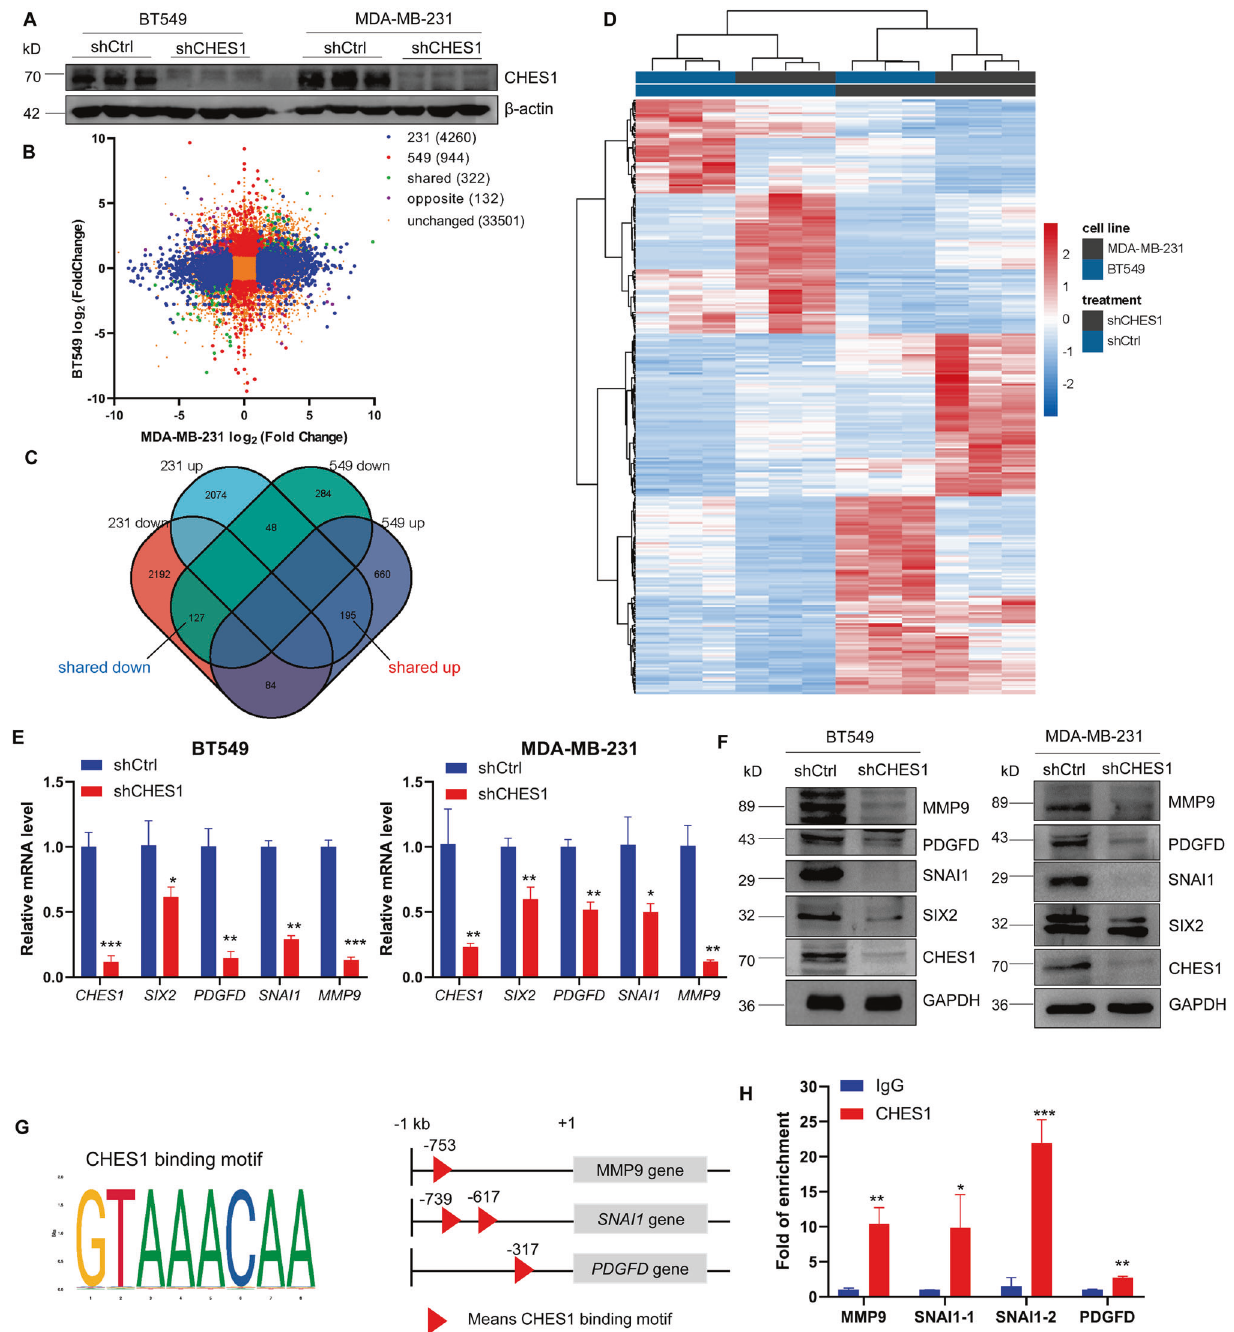
Fig. 2 RNA-seq data revealed the genes and pathways associated with CHES1 in TNBC. A Western blot showed the knockdown ef fi ciency of shCHES1 in BT549 and MDA-MB-231. B Clustering of RNA-seq data in MDA-MB-231 and BT549 with shCHES1. Signi fi cance was set based on padj < 0.05 and absolute fold-change > 2. C Venn diagram showed that 322 genes shared differentially expressed in both MDA-MB-231 and BT549 cells. D Heatmap showed the gene expression pattern of the 322 genes in both cell lines. E qPCR assay evaluated the mRNA levels of genes associated with CHES1 in BT549 and MDA-MB-231 cells. * p < 0.05, ** p < 0.01, *** p < 0.001. F Western blot detected the protein levels of factors associated with CHES1 in BT549 and MDA-MB-231 cells. G Schematic representation of the CHES1 binding motif and potential binding sites (red triangle) on the upstream of MMP9 , SNAI1 , and PDGF-D transcription start site. The data were analyzed and downloaded from the JASPAR dataset (https://jaspar.genereg.net/). H The enrichment of CHES1 in the promoter region of genes were evaluated by ChIP. * p < 0.05, ** p < 0.01, *** p <